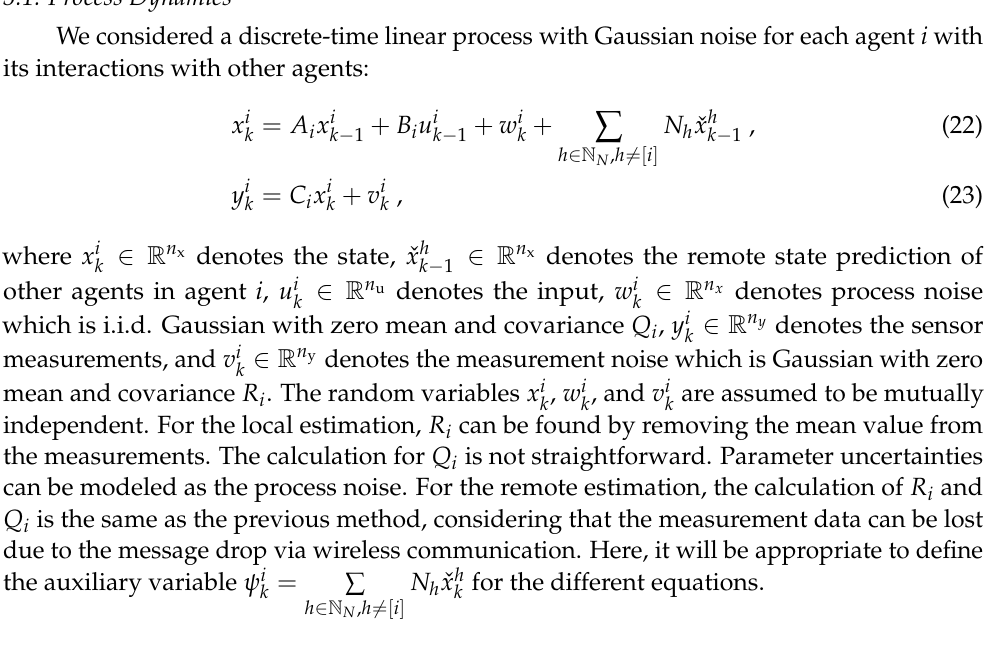
= 1) and is received by agent j with the probability of ν k